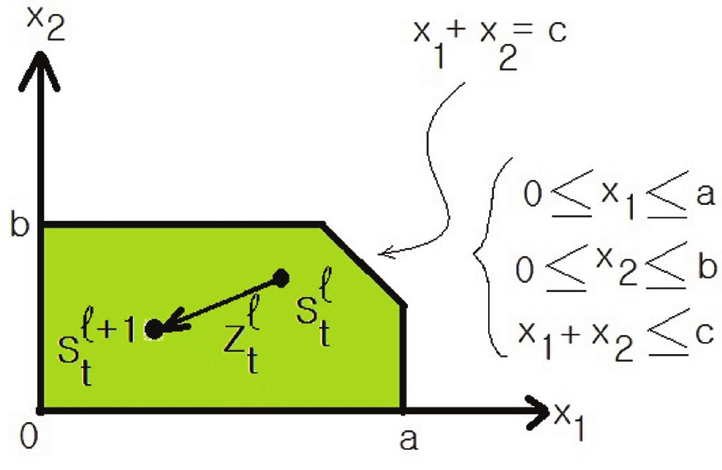
Figure 5. Two-dimensional representation of the state space and a sample action in iteration (cid:96) of time slot t